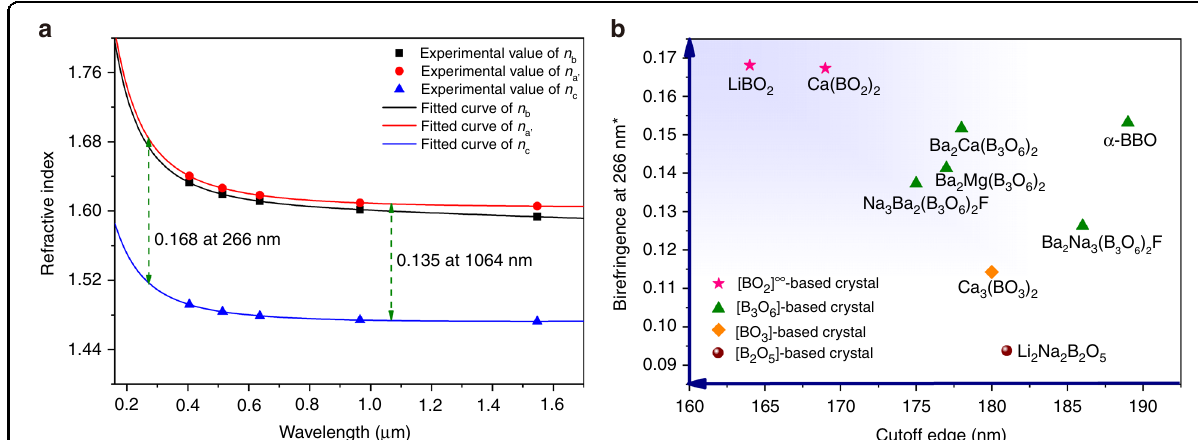
Fig. 2 Refractive indices and birefringence of LiBO 2 . a Measured refractive indices and the fi tted curves by the Sellmeier equations, where n a ′ represents the refractive index perpendicular to the b -axis in the (001) plane, n b and n c are refractive index along b - and c -axes, respectively. b Comparison of borate DUV birefringent crystals based on different [BO] groups. *Data for LiBO 2 are Δ n ′ while for other crystals are calculated from Sellmeier equations (Refs. 23,35 – 41